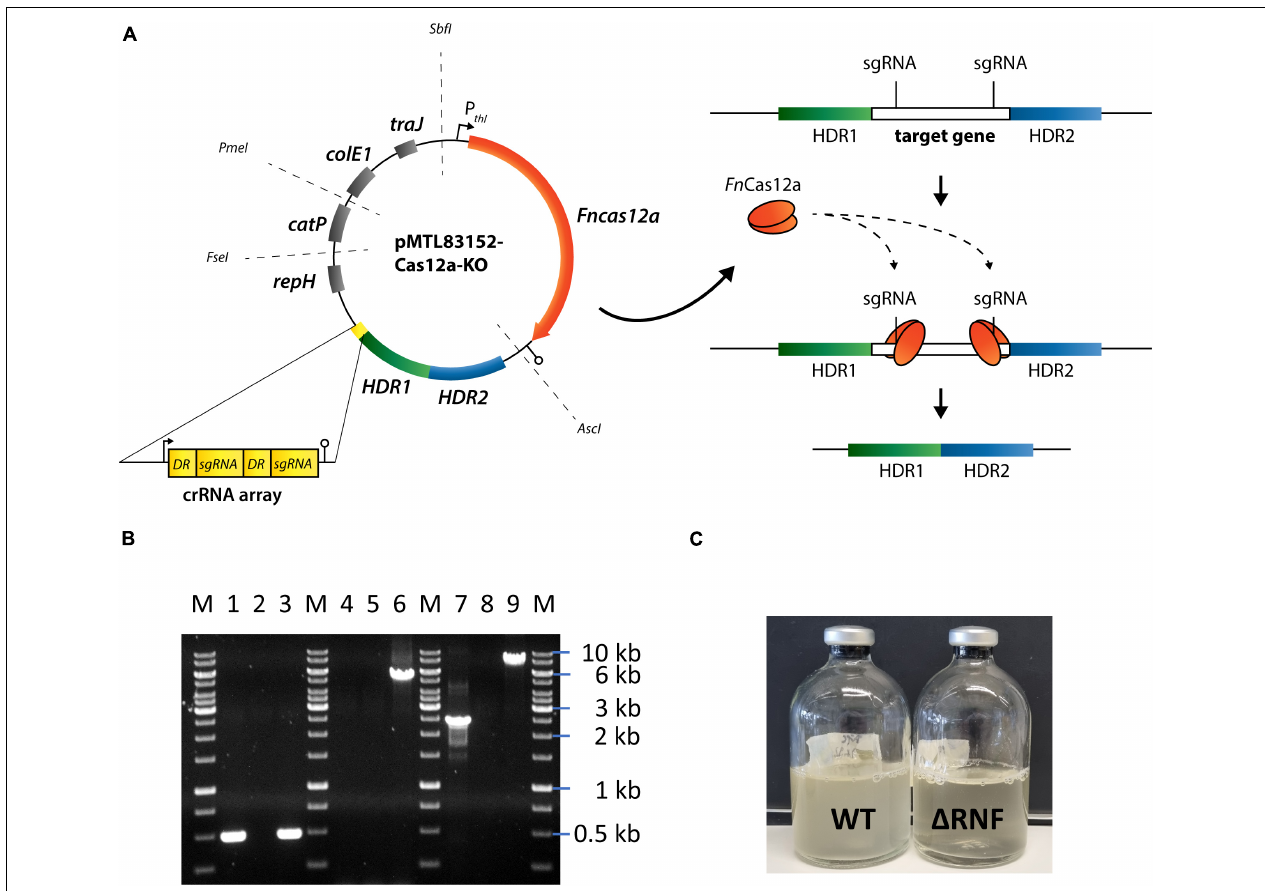
FIGURE 1 | CRISPR-Cas12a-mediated rnfCDGEAB gene cluster deletion in C . ljungdahlii . (A) Modular CRISPR-Cas12a system established in the pMTL80000 shuttle-vector system (Heap et al., 2009). The final CRISPR-Cas12a plasmid for deletion of rnfCDGEAB contained the Fncas12a gene, homology-directed repair arms (HDRs), and a specific crRNA array comprising two directed repeats (DRs) and two sgRNA, which targeted the rnfC and rnfB genes. (B) Agarose gel with PCR-samples for the fdhA fragment (WT: 501 bp, deletion strain: 501 bp), rnfCDGEAB fragment (WT: 5,047 bp, deletion strain: no fragment), and for a fragment that was amplified with primers that bind ∼ 1,250 bp upstream and downstream of the rnfCDGEAB gene cluster locus (WT: 7,550 bp, deletion strain: 2,503 bp). DNA-template: gDNA of C. ljungdahlii (cid:49) RNF (lane 1, 4, and 7); gDNA of C. ljungdahlii WT (lane 3, 6, and 9); and water (lane 2, 5, 8). M: Generuler TM 1 kb DNA ladder. (C) Growth of the wild type (WT) and reduced growth of the deletion strain ( (cid:49) RNF) with fructose in PETC medium. HDR1/2, homology-directed repair arm flanking the targeted gene; crRNA array, sequence containing FnCas12a-specific DRs and sgRNAs; sgRNA, guide RNA; repH , Gram-positive origin of replication; catP , antibiotic resistant cassette against chloramphenicol/thiamphenicol; colE1 , Gram-negative origin of replication; traJ , conjugation gene; P thl , promoter sequence of the thiolase gene in Clostridium acetobutylicum ; Asc I, Fse I, Pme I, and Sbf I are unique-cutting restriction sites, which were preserved during the cloning to maintain the modular functionality of the plasmid